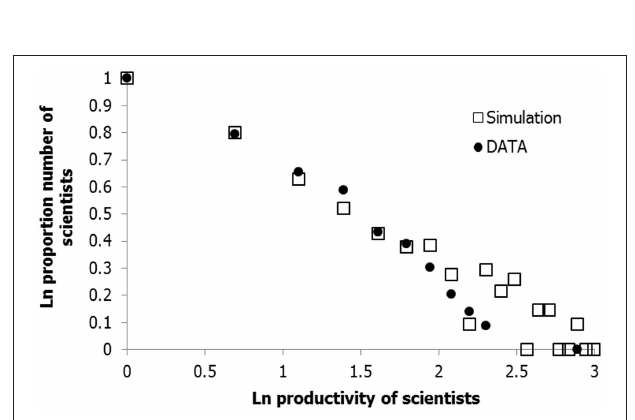
FIGURE 11 | Log-log plot of the number of articles published in high ranked economics journals against proportional number of authors.